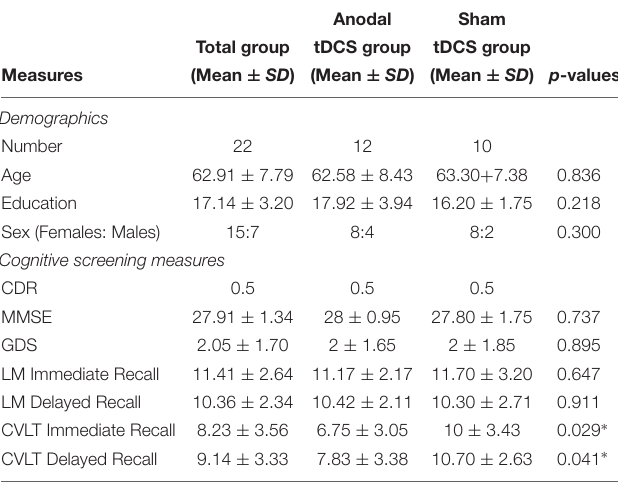
TABLE 1 | Demographics and clinical characteristics (Cognitive Screening Measures).